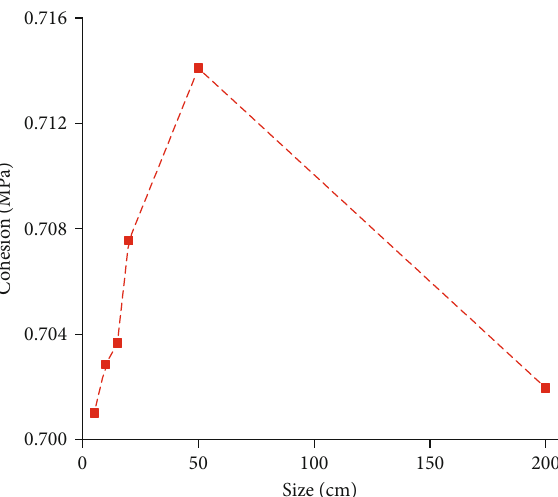
Figure 13: Relationship between cohesion and model size.